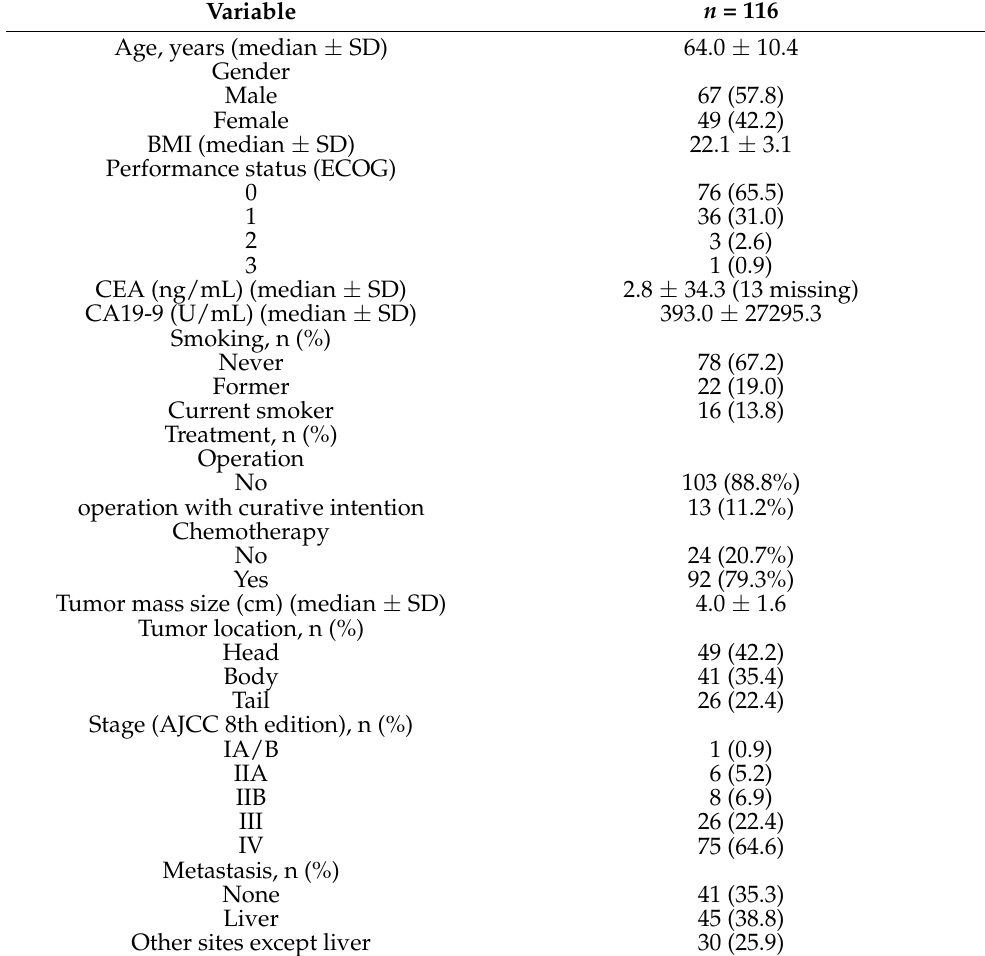
Table 1. Clinicopathologic Characteristics of Patients with Pancreatic Cancer.